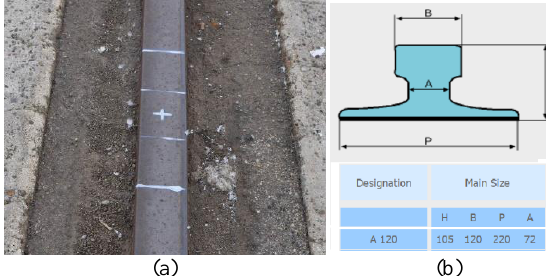
Figure 6. Crane rail under investigation. a) Panoramic photo of sections highlighted by standards frame for direct survey; b)